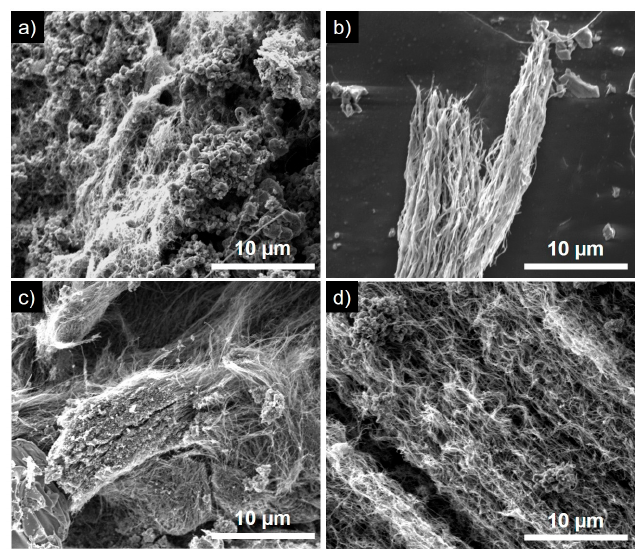
Figure 6. SEM images of DLICVD experiments conducted using an aspiration temperature of 225 °C, a 1 mL/h injection rate, a 1.25 wt.% catalyst concentration, using EtOH as a carbon source, and a reaction temperature of ( a ) 700 °C, ( b ) 800 °C, ( c ) 900 °C, and ( d ) 1000 °C.